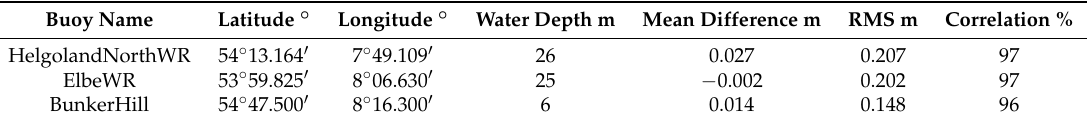
Table 1. Comparison statistics between the numerical wave model and wave buoy observations at three different